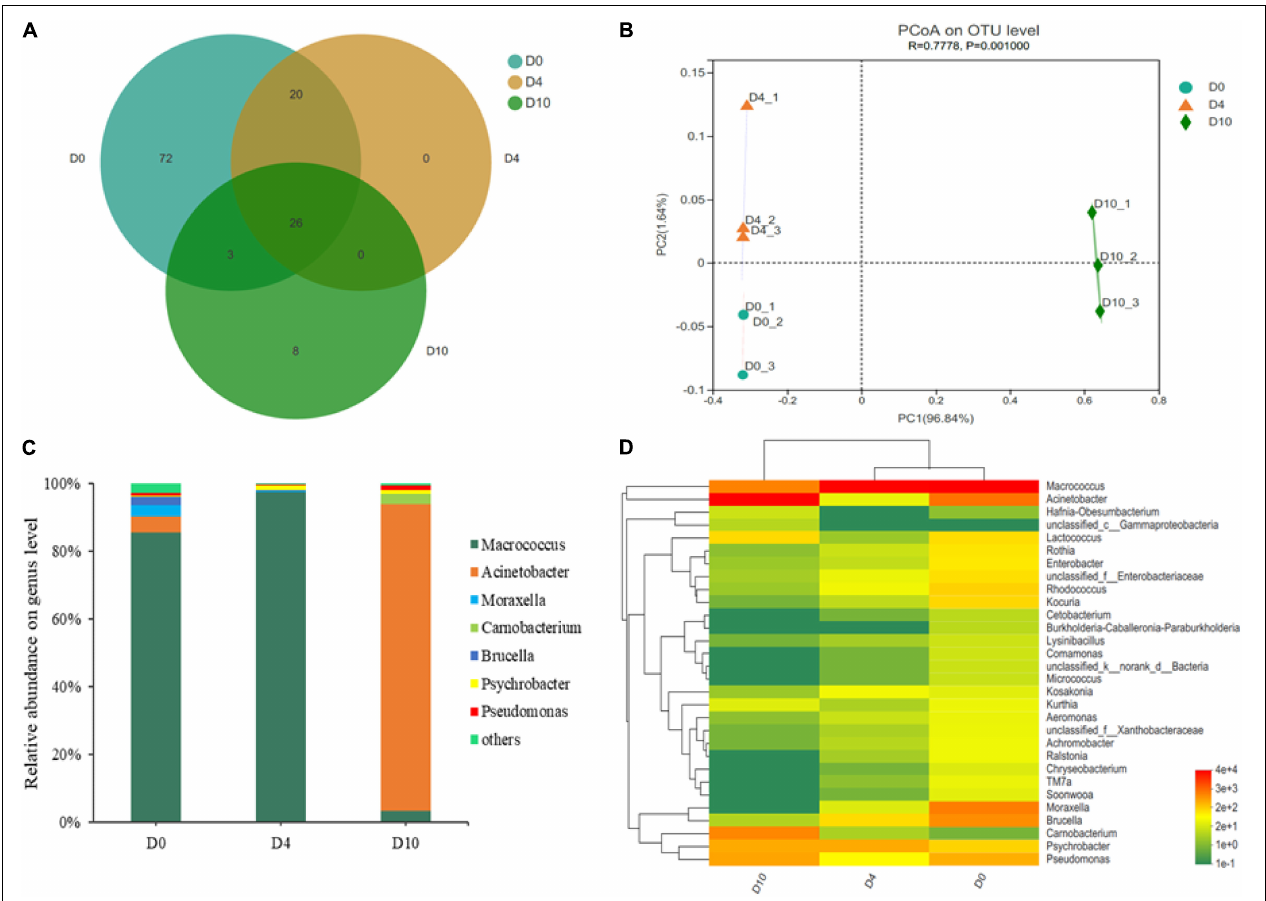
FIGURE 3 | The Venn diagram shows the unique and shared bacterial population (A) , principal coordinate analysis of the bacterial community (B) , dynamics in relative abundance (%) of bacterial community at genus level (C) , and a heat map analysis of microbiota at the genus level (D) in sturgeon filets during storage at 4 ◦